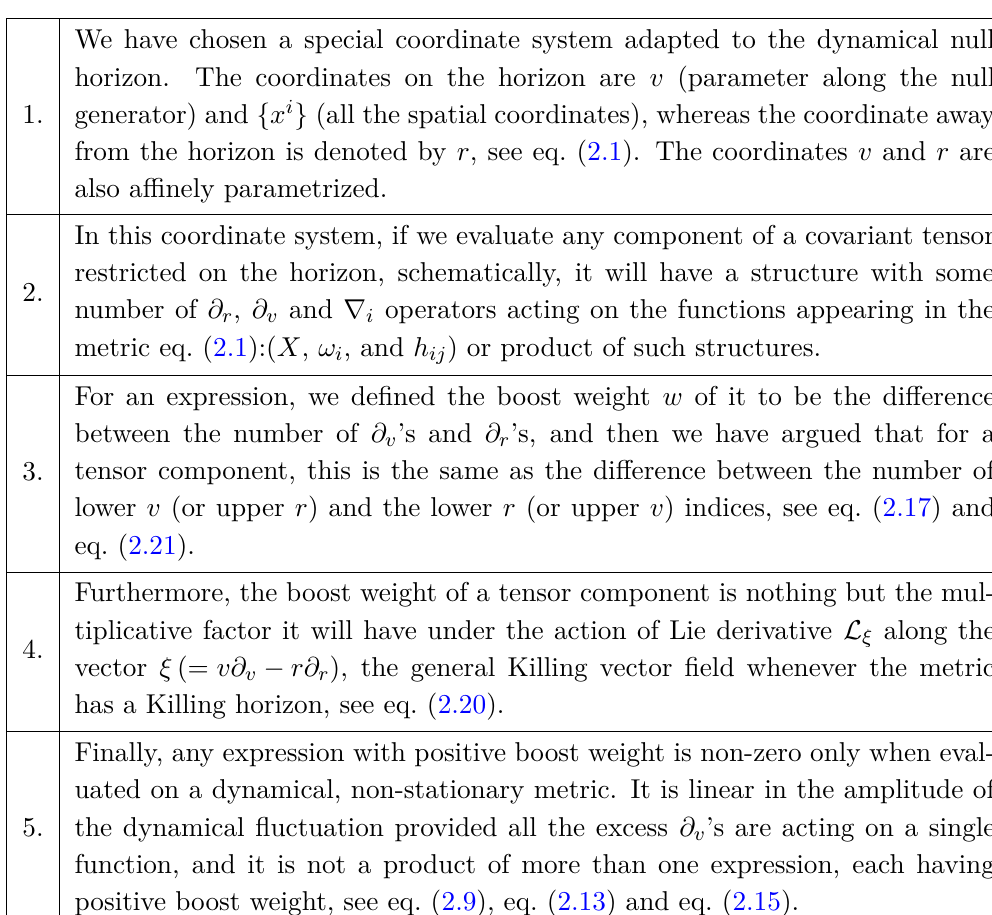
Table 3 . Summary of the important lessons so far that will serve as guidelines for later computa-